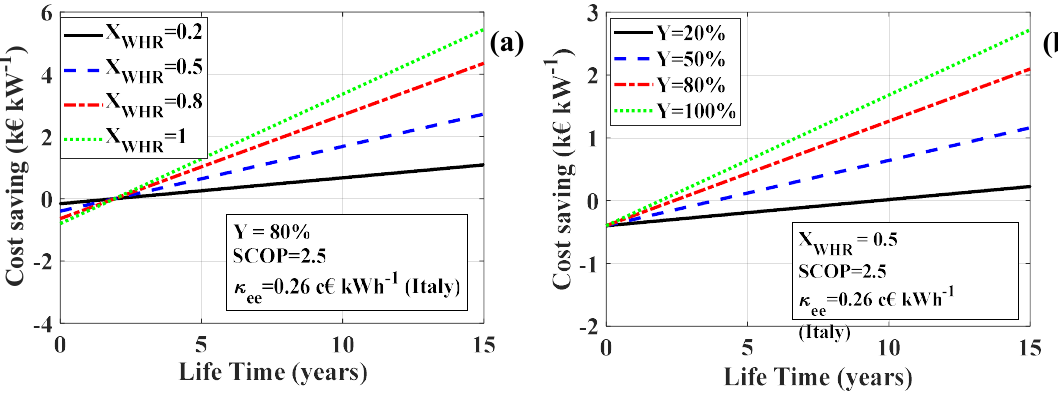
Figure 10. Specific cost savings as a function of the operating time of the combined plant (4000 working hours per year are considered). Seasonal COP (SCOP) and κ ee are, respectively, fixed to 2.5 and 0.26 c€ kWh −1 (Italian market [46]). ( a ) Effect of the WHR plant size for Y = 0.80; ( b ) effect of the waste heat availability for X WHR = 0.5.